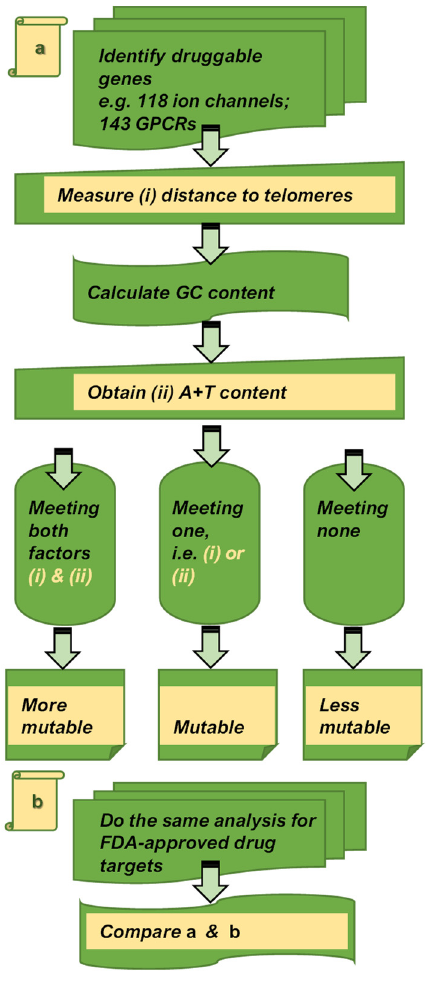
Figure 5. Flow chart summarizing how chromosomal analyses are conducted in this study ( a ) dia- grams showing the logical flow of tasks on druggable genomes ( b ) diagrams displaying tasks on FDA ‐ approved drug targets and amalgamation of the dataset in a and b.